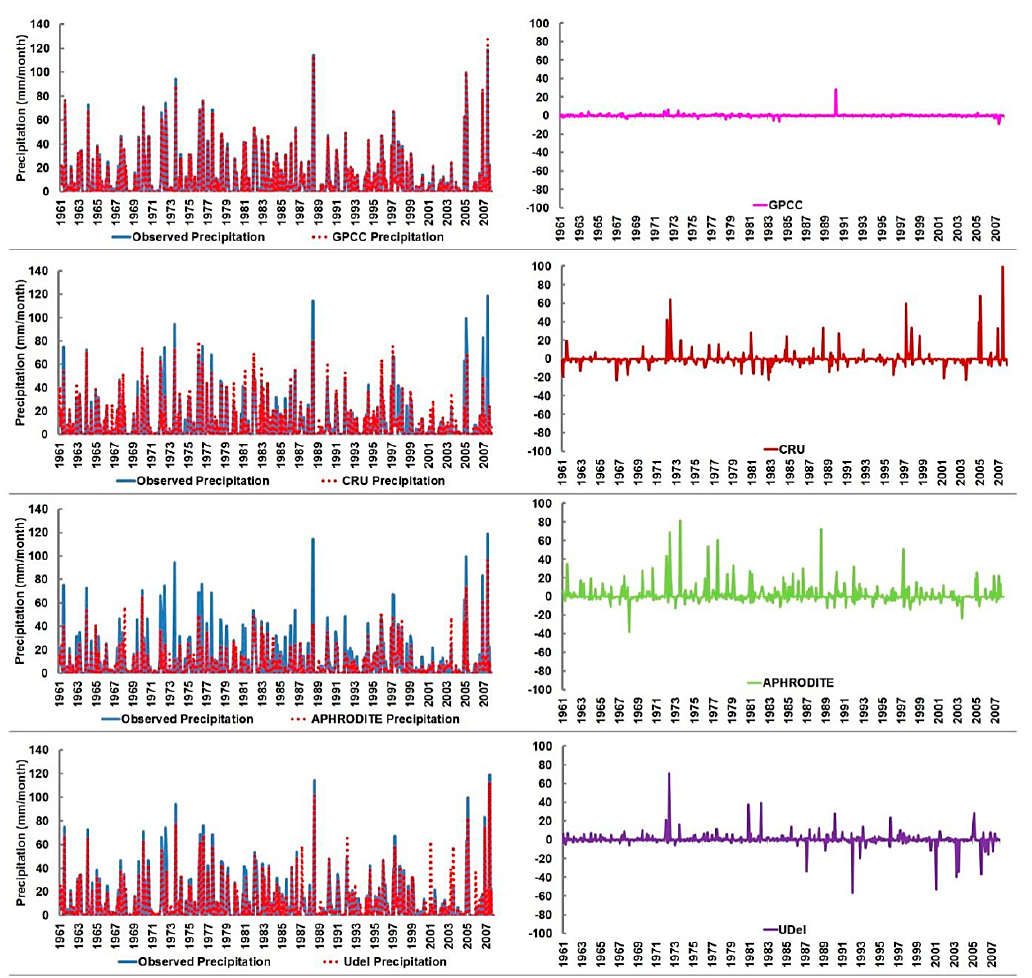
Figure 4. Time series of observed with gauge-based gridded precipitation; and their differences (residuals) at the arid region.